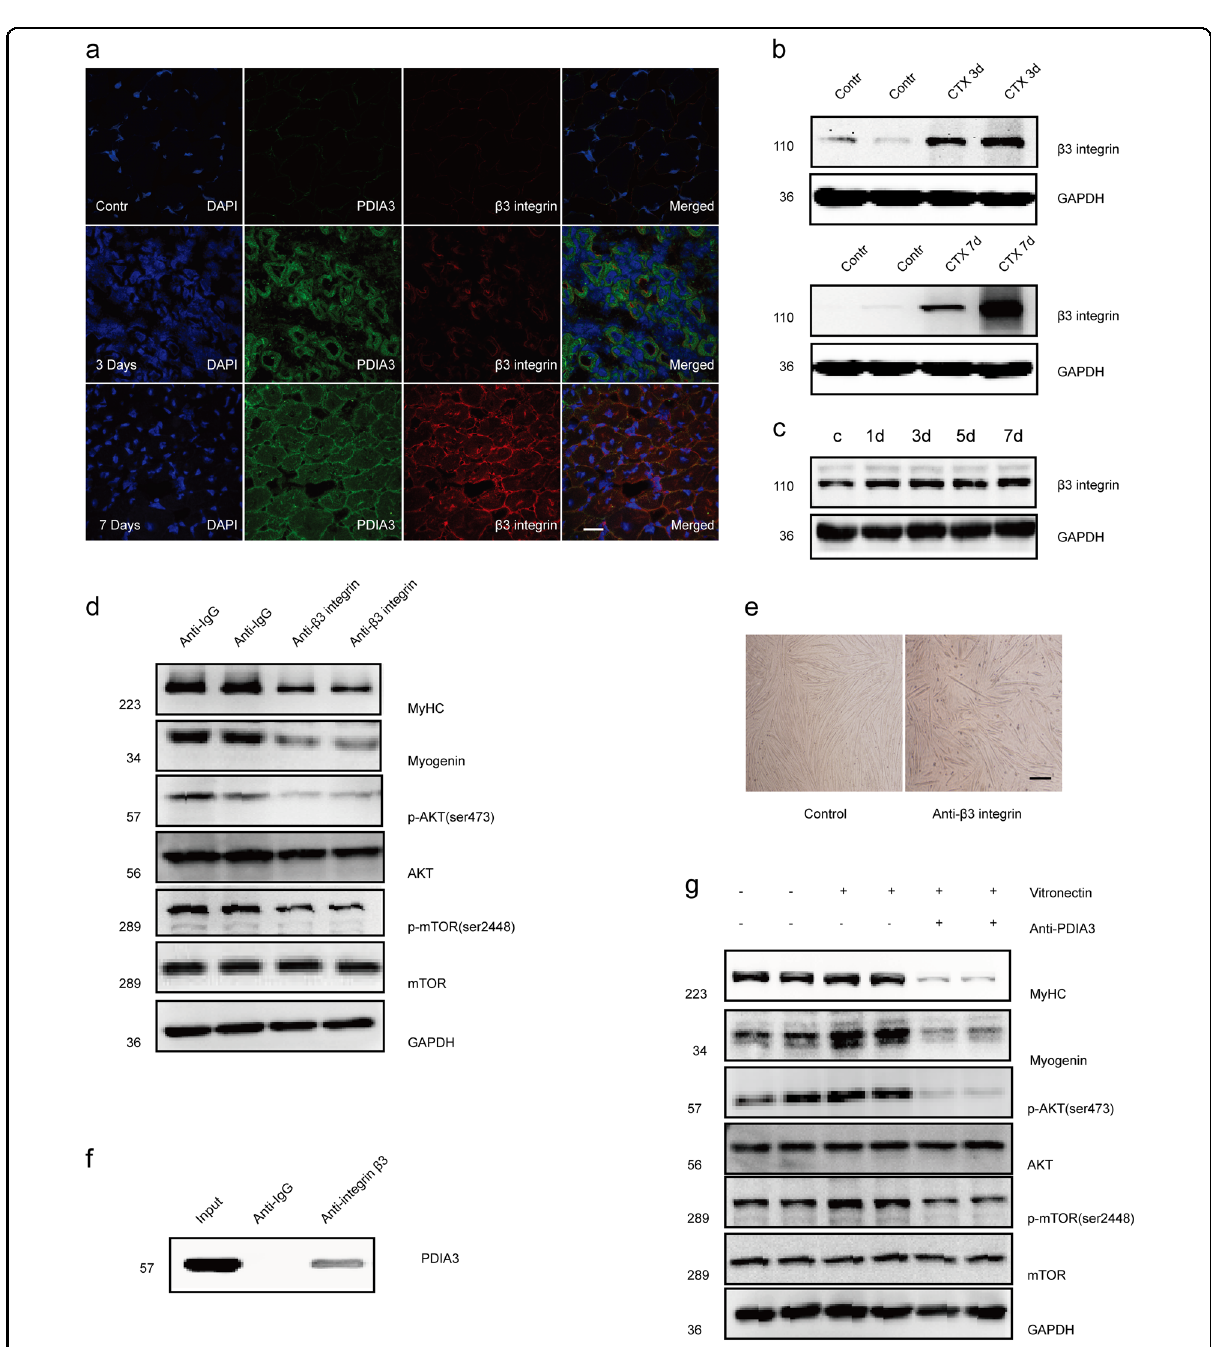
Fig. 8 PDIA3 regulates β 3 integrin-mediated myoblast differentiation and fusion. a Frozen sections of gastrocnemius muscle were subjected to the immuno fl uorescence costaining of β 3 integrin and PDIA3. Scale 20 µm. b The gastrocnemius in mice were injured by the direct injection of 100 µl CTX (10 µM) and collected at 3 and 7 days after injury. The level of β 3 integrin protein was measured by immunoblotting. ( n = 4). c C2C12 myoblasts were subjected to differentiation for 1, 3, 5, and 7 days. The β 3 integrin levels were measured by immunoblotting ( n = 4). d C2C12 myoblasts were induced to differentiate for 48 h, followed by monoclonal anti- β 3 integrin (10 µg/ml) treatment for 24 h. The levels of p-AKT, AKT, p- mTOR, mTOR, myogenin, and MyHC were measured by immunoblotting ( n = 4). e C2C12 myoblasts were induced to differentiate for 48 h, followed by monoclonal anti- β 3 integrin (10 µg/ml) treatment for 72 h. Myotube formation was observed by a microscope. Scale 200 µm. f The gastrocnemius in mice were injured by the direct injection of 100 µl CTX (10 µM) and collected at 7 day after injury. The muscle lysates were subjected to immunoprecipitation with an anti-PDIA3 antibody and were immunoblotted with anti- β 3 integrin antibody ( n = 4). g C2C12 myoblasts were induced to differentiate for 48 h and incubated with recombinant human vitronectin (2 µg/ml) for 24 h in the absence or presence of an anti-PDIA3 (10 µg/ml) antibody. The levels of p-AKT, AKT, p-mTOR, mTOR, myogenin, and MyHC were measured by immunoblotting ( n = 4).